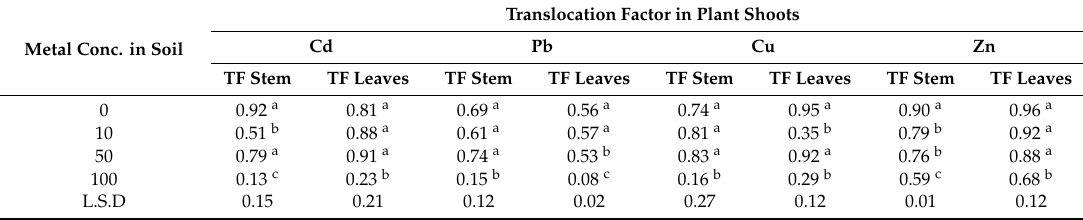
Table 2. Translocation factors (TF) of Cd, Pb, Cu and Zn in R. stricta plants grown in soils treated with heavy metal concentrations of 10, 50 and 100 mg / kg and natural soil as a